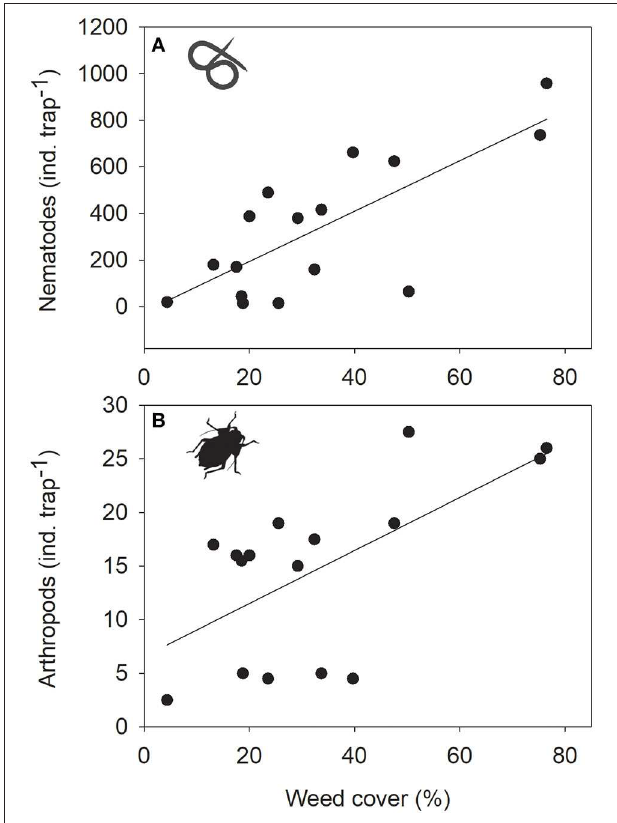
FIGURE 4 | Relationship between weed cover and densities of phytophagous (A) nematodes and (B) arthropods across orchard plots. Note that N = 16 for weed